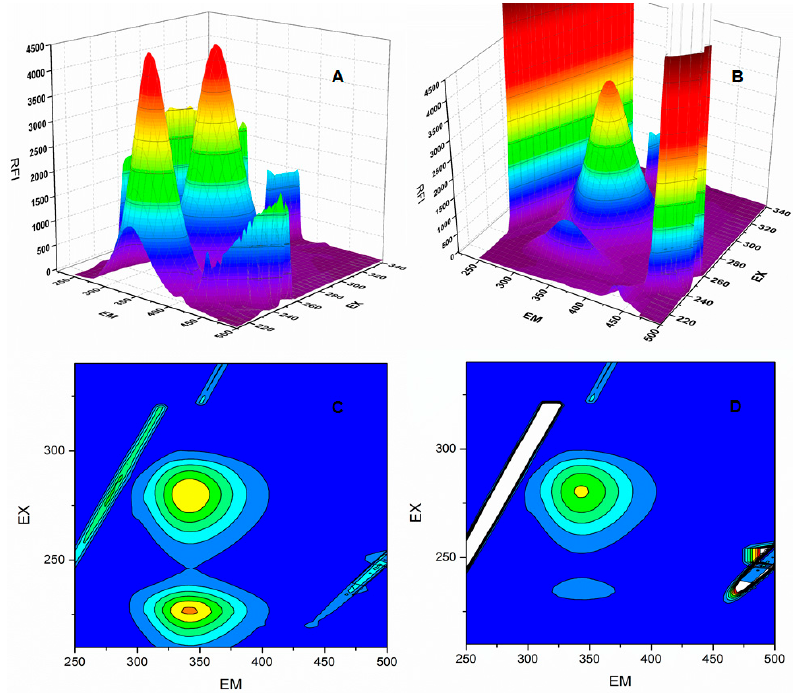
Figure 6. Three-dimensional fluorescence (3D) spectra and contour spectra of BSA ( A) and ( C ) and BSA– 6P ( B) and ( D ) complex BSA.